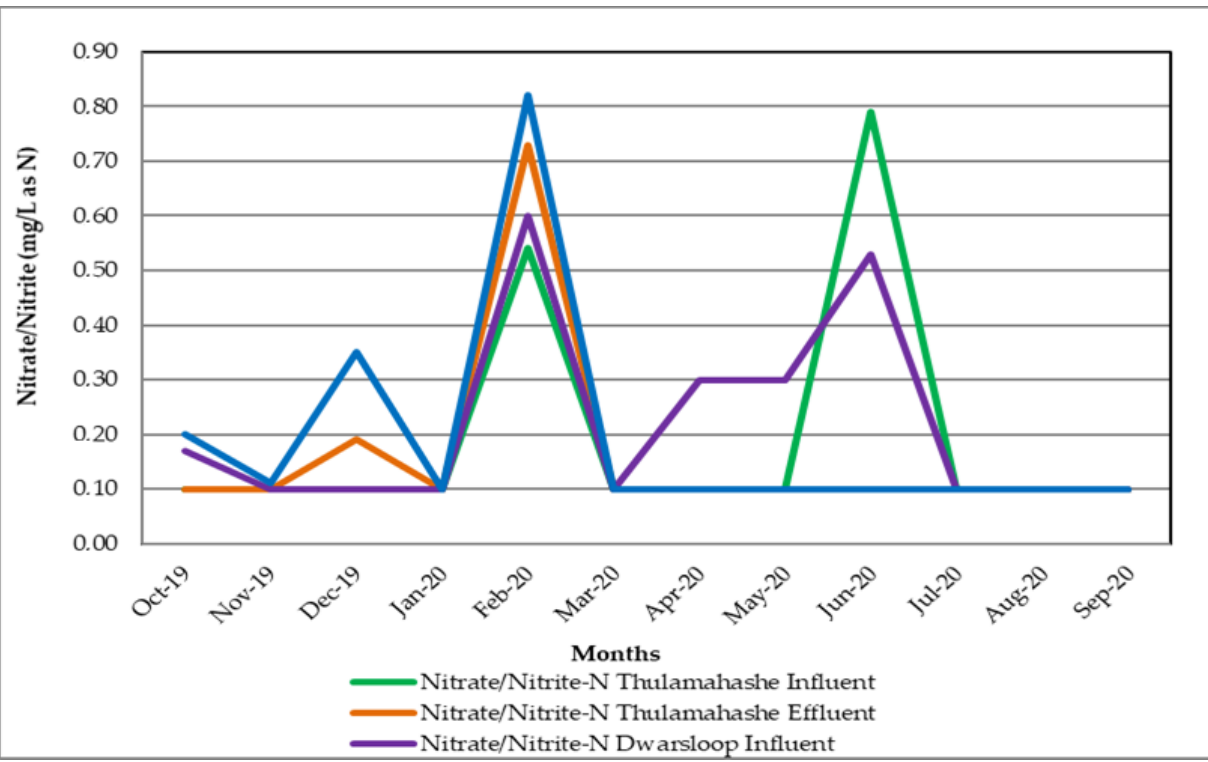
Figure 9. WWTWs performance in terms of Nitrate/Nitrite-Nitrogen.